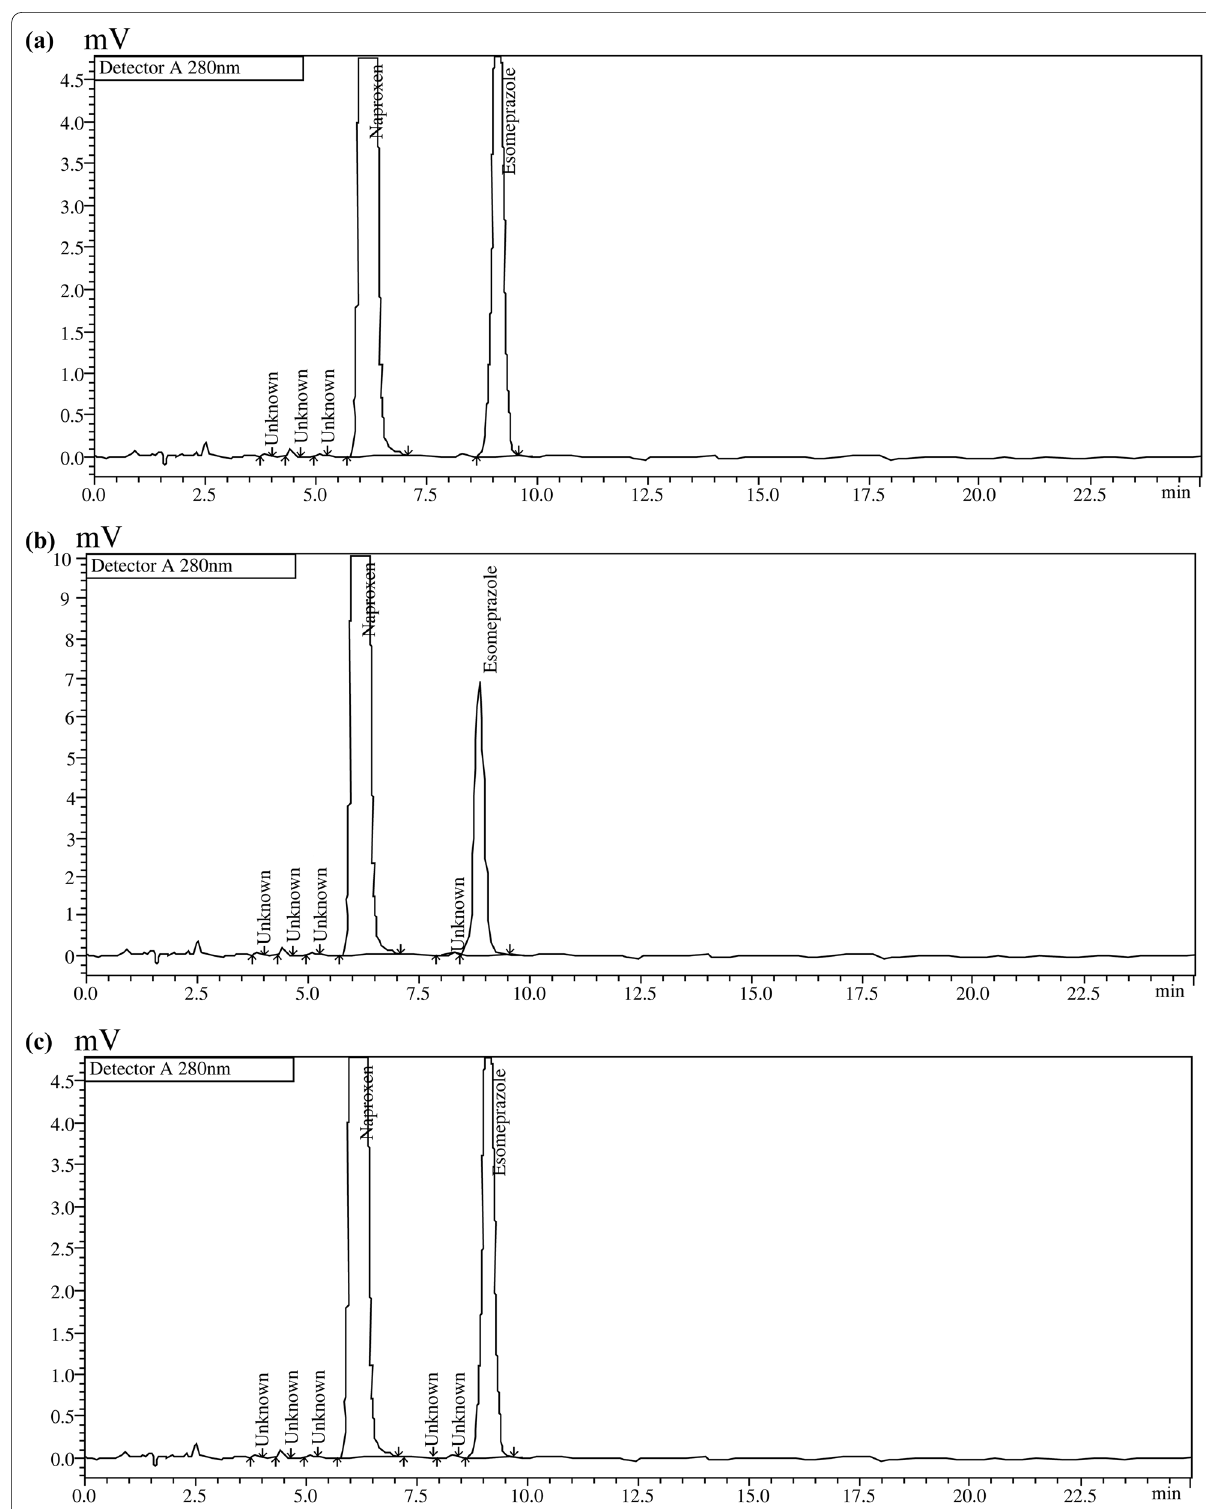
Fig. 7 Representative chromatograms of forced degradation study a API, 0.01 N HCl at 40 °C, b API with placebo mix at 40 °C, 75% RH, c API with placebo mix at 60